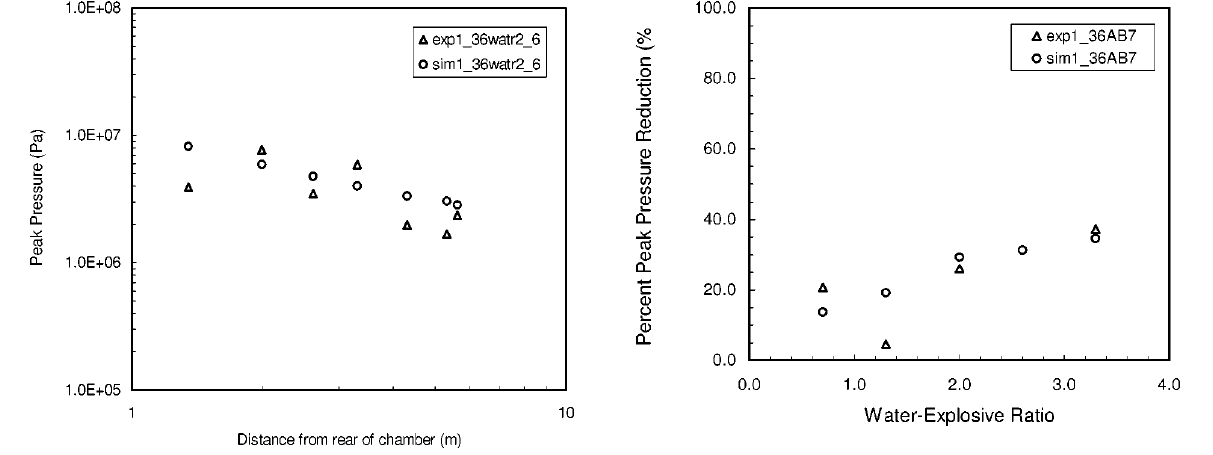
Fig. 13. Percent peak pressure reduction versus water-explosive ratio for location AB-7.